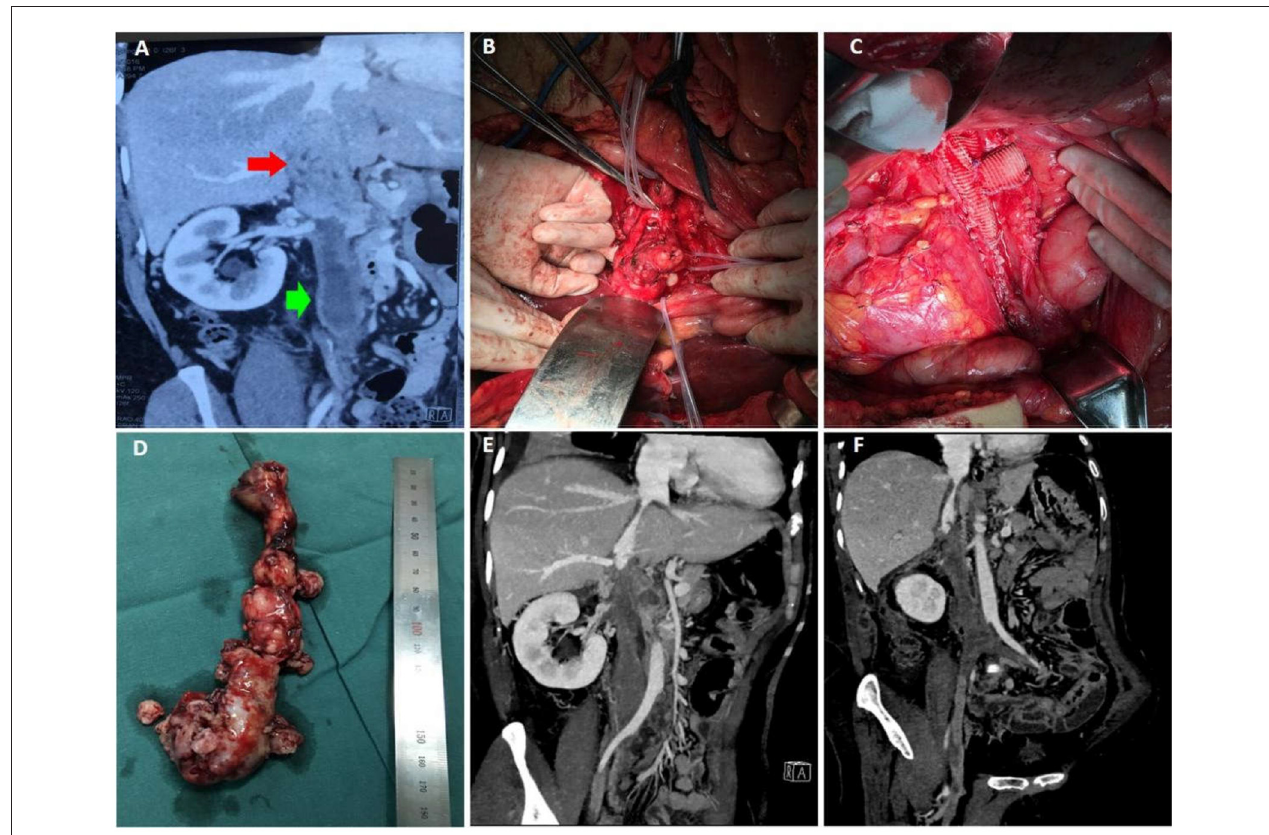
FIGURE 3 | Data of case 3 before, during, and during follow-up. (A) Preoperative CTV suggested a space-occupying lesion of the inferior vena cava, which started at the level of the junction of the hepatic vein and elongated to the junction of the renal vein. (B,C) During the operation, the liver was dissociated and the first and second hilum were controlled with tourniquets. After complete resection of the inferior vena cava mass, artificial vascular patches were used to reconstruct the inferior vena cava. (D) The intact mass was removed. (E,F) Ten days after surgery, CTV confirmed that the inferior vena cava was unobstructed and the prognosis was